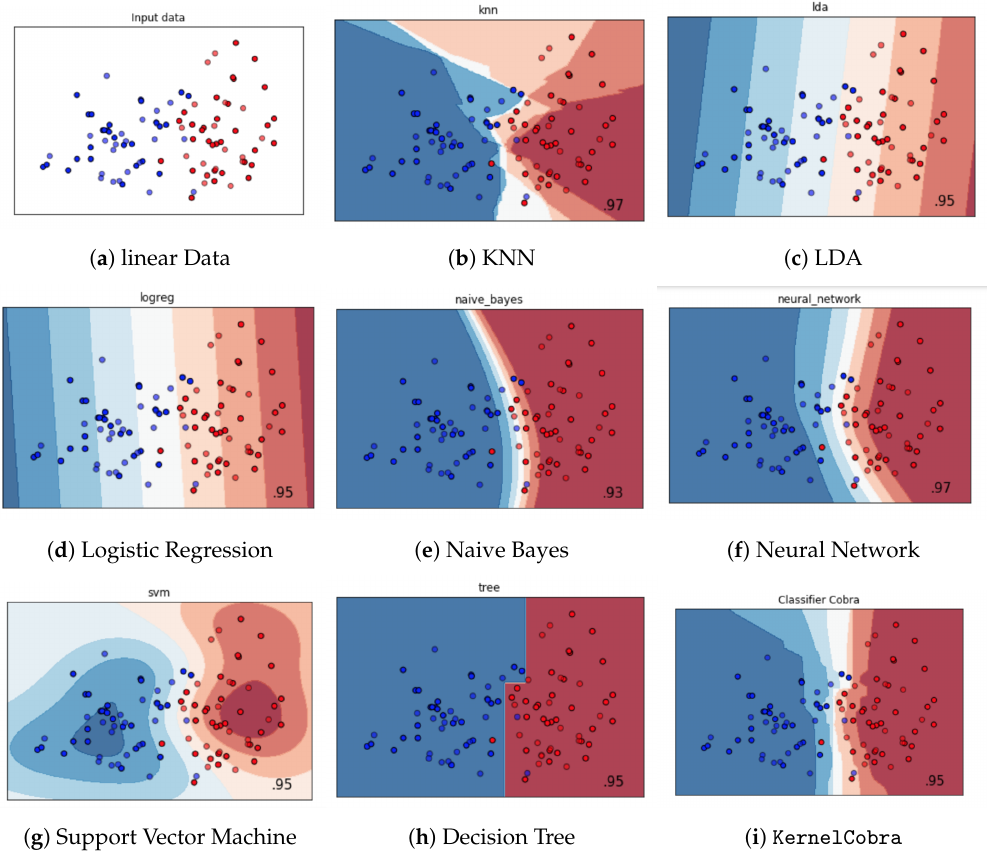
Figure 5. Decision boundaries of base classifiers and KernelCobra on the linear